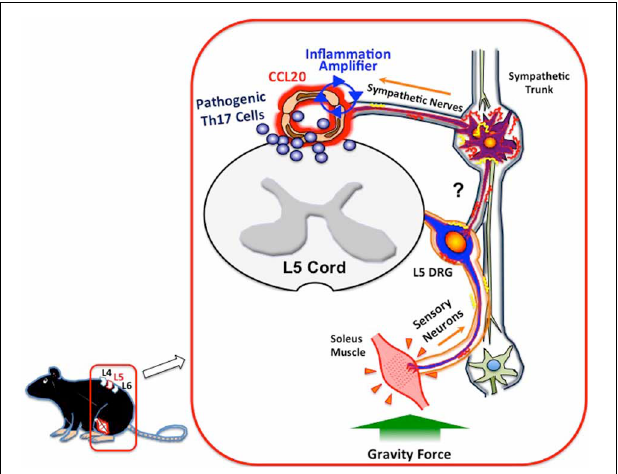
FIGURE 3 | Gateway for autoreactive T cells into the CNS. Continuous stimulation of the soleus muscles by gravity leads to the constant activation of L5 DRG sensory neurons, followed by the activation of sympathetic neurons at the L5 region via unidentified circuits (?). NE, a neurotransmitter from sympathetic neurons, augments the inflammation amplifier at the dorsal vessels of L5, causing an elevation of CCL20 and subsequent Th17 infiltration into the CNS.